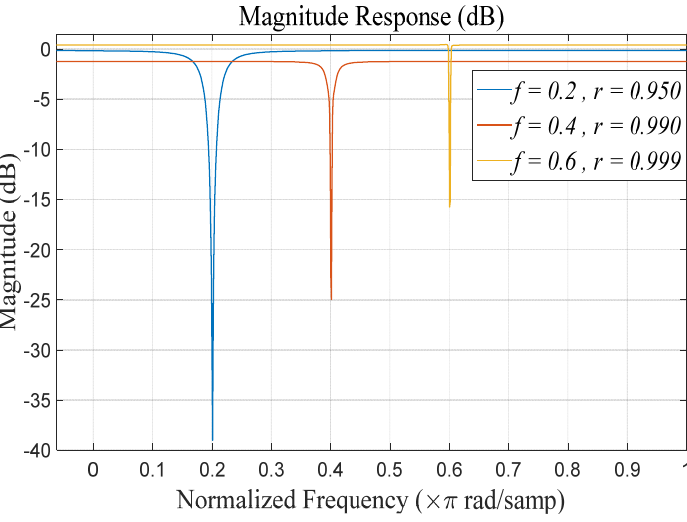
Figure 8. Notch filters with different (cid:1870) parameters.